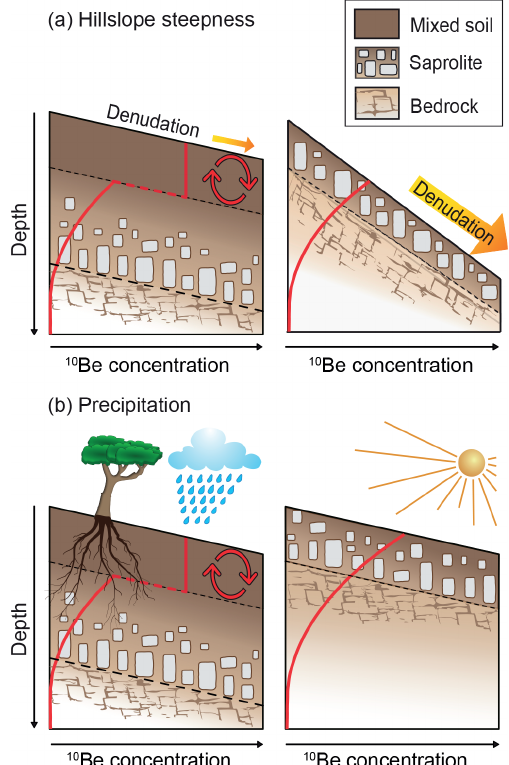
Figure 2. The effect of hillslope steepness and precipitation on the depth of the mixed soil layer and 10 Be concentrations as a function of depth. (a) Hillslope steepness and denudation rates control the thickness of the soil mantle by the removal of material from the top. A thick soil mantle likely develops in gently sloping and slowly eroding landscapes, whereas high denudation rates in steep land- scapes prohibit the development of a thick soil mantle. (b) Precipi- tation provides water for chemical weathering. Humid landscapes likely develop a thick soil mantle, which may be absent in arid landscapes. Bioturbation in landscapes with thick soil mantles re- sults in a well-mixed soil layer with a uniform 10 Be concentration, which, in isotopic steady state, is equal to the surface concentration. In landscapes where a mixed soil layer is absent, 10 Be concentra- tions decrease exponentially with